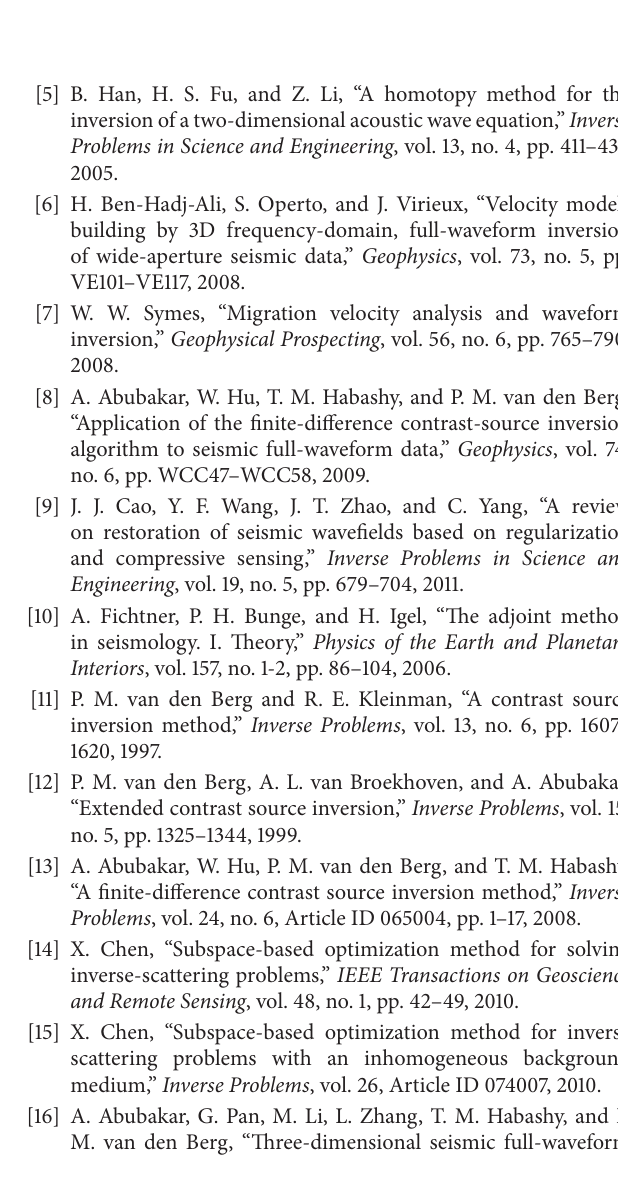
Figure 4: Applying sequential multifrequency technique to improve reconstruction results. (a) Reconstruction result of one square scatterer model. (b) Reconstruction result of two rectangle scatterers